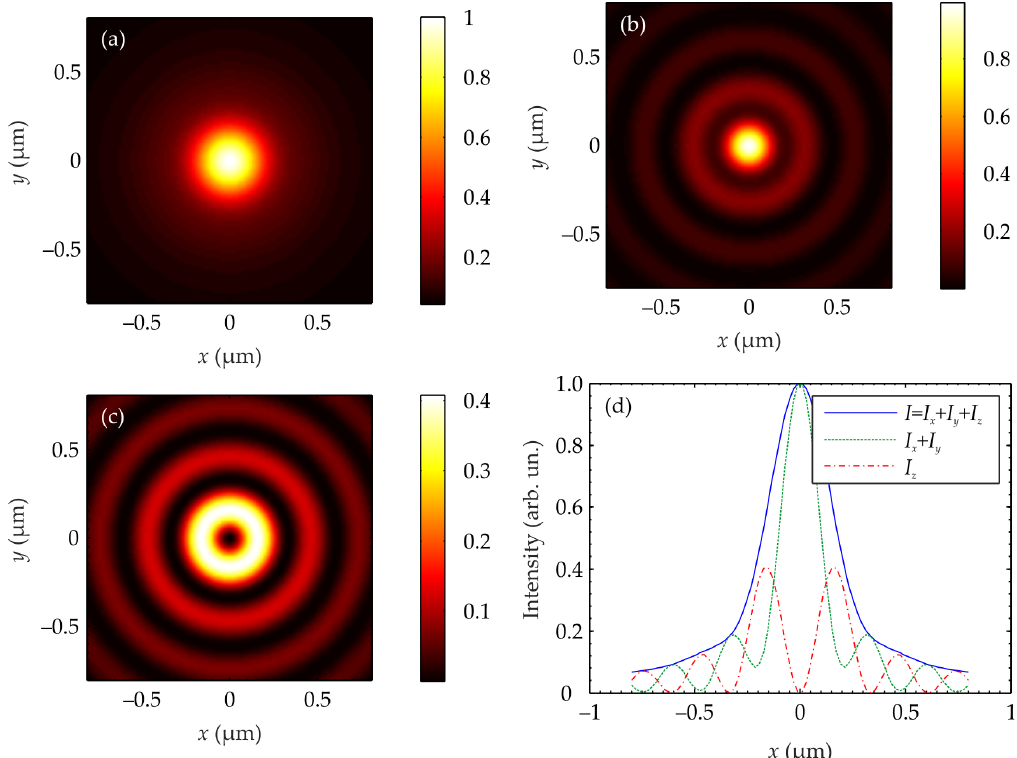
Figure 4. Distributions of intensity at the focus ( a ) and intensity components I r ( b ) and I z ( c ) when focusing light with a flat diffractive lens with NA = 0.999. The intensity profile along the x ‐ axis ( d ).